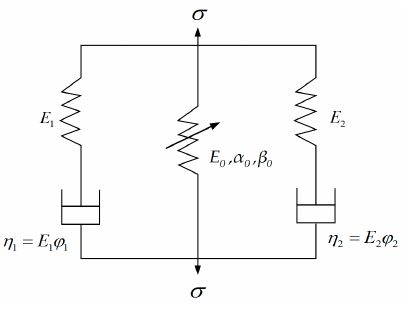
Figure 12. ZWT model.